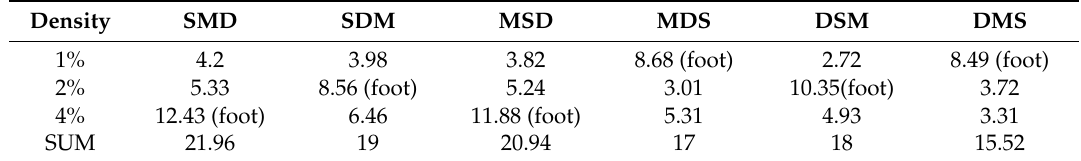
Table 5. Manning coefficients for different density arrangement